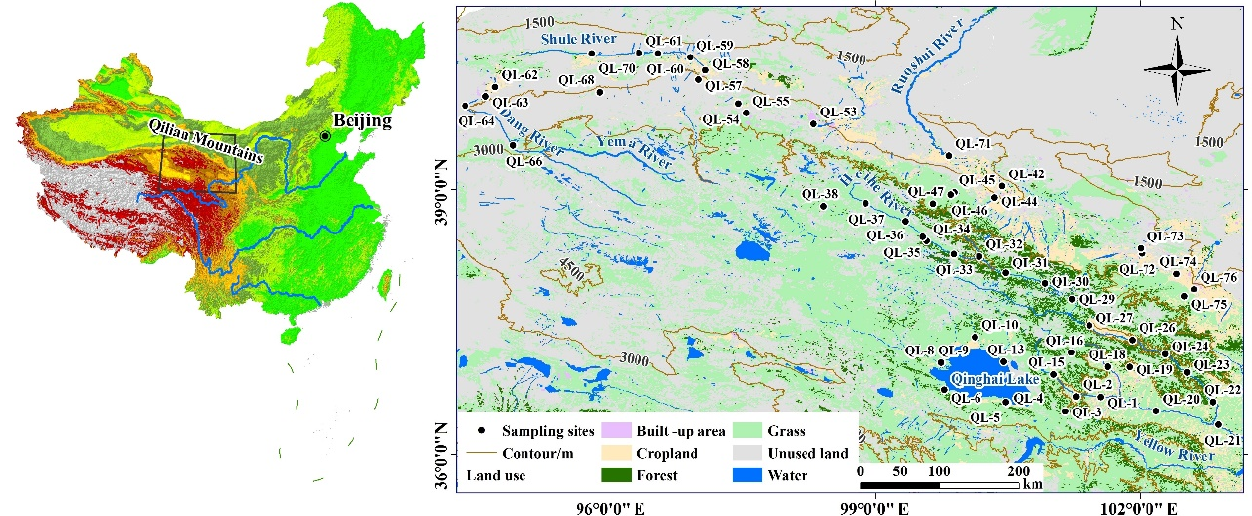
Figure 1. Map of the study watershed and the sampling locations.